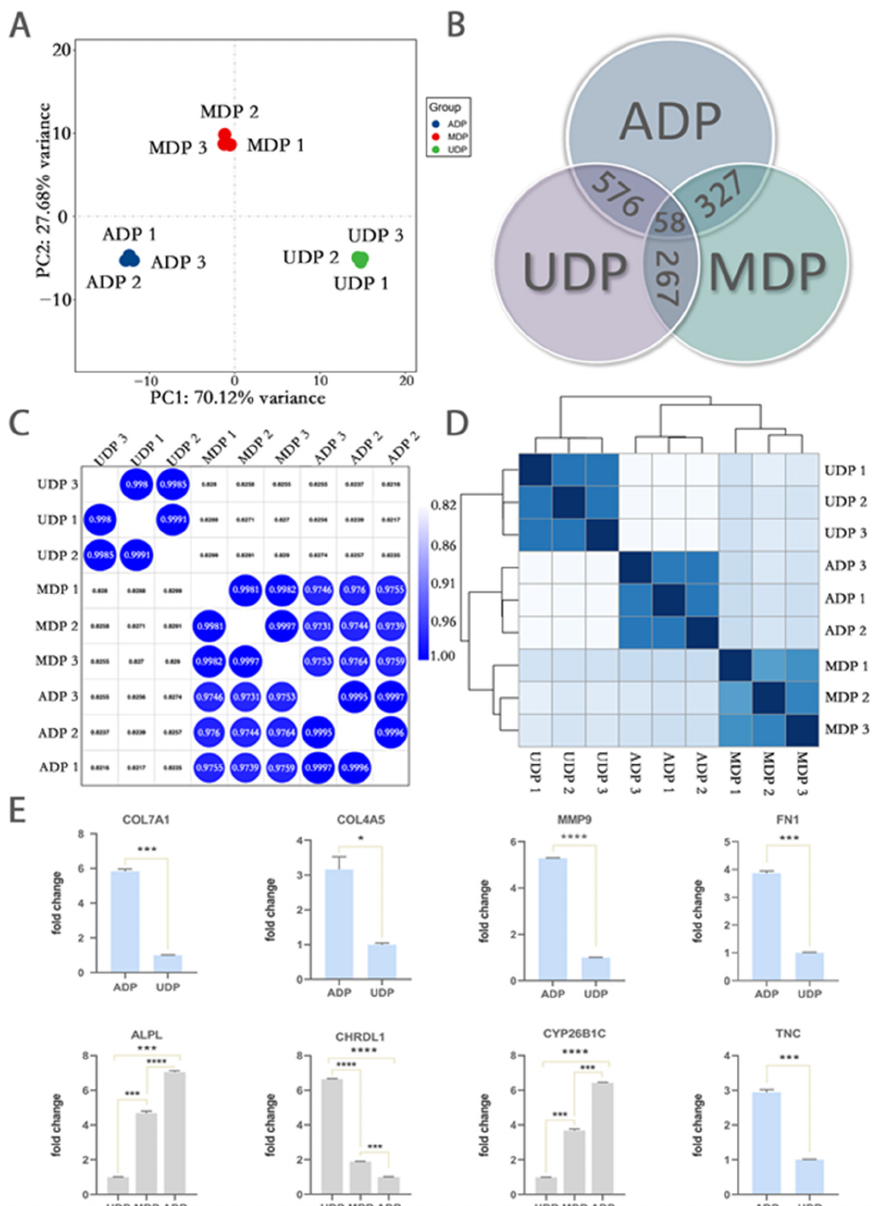
Figure 3. A general view of gene expression pattern and RT-PCR verification on selected DEGs. ( A ) The PCA analysis is performed on the transcript signatures of fixed 2D patterned DP cells (UDP), the re-aggregating DP cells (MDP), and restored 3D patterned DP cells (ADP). PC1 explained 70.12% of the overall variation. The distance between ADP and MDP is significantly shorter than that between MDP and UDP in PC1. ( B ) Venn analysis is performed on differentially expressed genes (DEGs) of UDP, MDP, and ADP. In total, 267 DEGs are expressed between MDP and UDP, 327 DEGs are expressed between MDP and ADP and 576 DEGs are expressed between ADP and UDP (|log2foldchange| ≥ 2, adjusted p value ≤ 0.05). Among them, 11 co-expressed DEGs in UDP, MDP, and ADP are further selected (|log2foldchange| ≥ 2, adjusted p value ≤ 0.05). ( C ) The correlation analysis is performed on the transcript signatures of UDP, MDP, and ADP. The average correlation coefficient between ADP and MDP is 0.98 (range: 0.97–0.98), whereas between ADP and UDP is 0.82 (range: 0.82–0.83) and between MDP and UDP is 0.83 (range: 0.826–0.829). ( D ) The hierarchical clustering analysis is performed on the transcript signatures of UDP, MDP, and ADP. Compared to UDP, MDP and ADP independently cluster together. ( E ) Verification of transcriptome results on the selected DEGs (RT-PCR, three individual wells/cell type) during the process of ADP re-formation, * p < 0.05, *** p < 0.001, **** p < 0.0001 (paired t